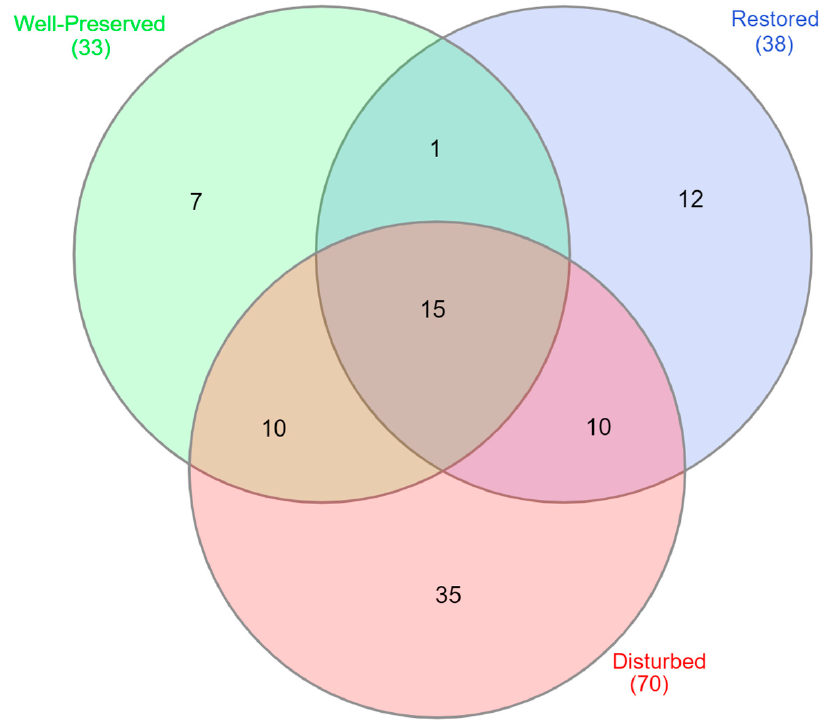
Figure 6. Venn diagram showing the summary of the number of unique taxonomic orders found in the three different mangrove conditions.